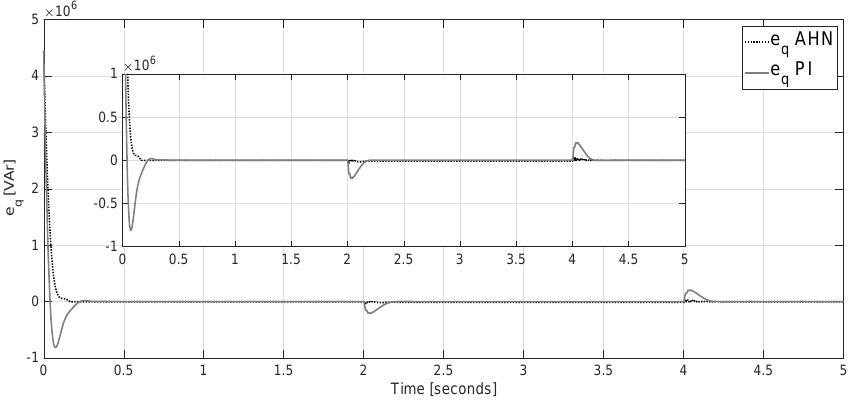
Figure 19. Simulation of the regulation error e q of reactive power during Test 2.